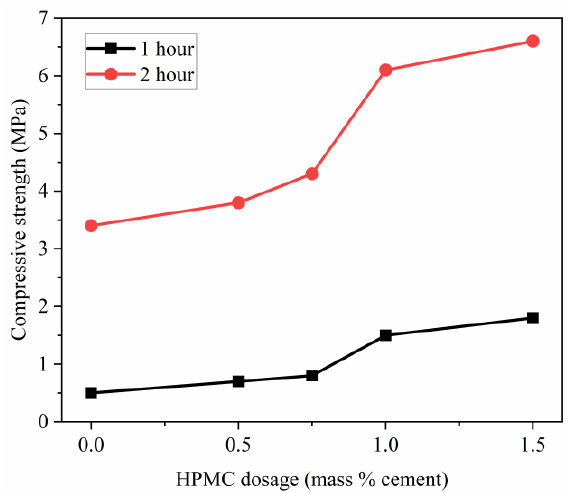
Figure 11. Compressive strength of mortar with W/C of 0.40, HPMC dosage of 1%, and S/C ratio of 2.